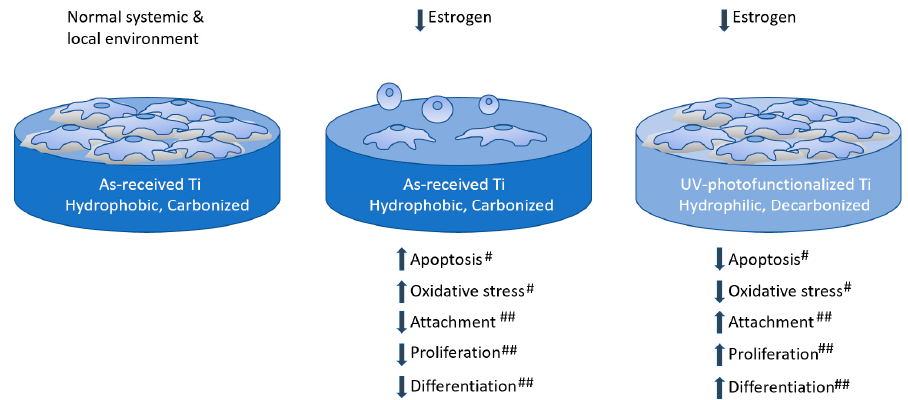
Figure 8. Scheme illustrating the proposed effect underlying the enhancement of attachment, proliferation, and differentiation of osteoblasts by UV-photofunctionalization in osteoporosis model. “#” and “##” indicates the associated strength.